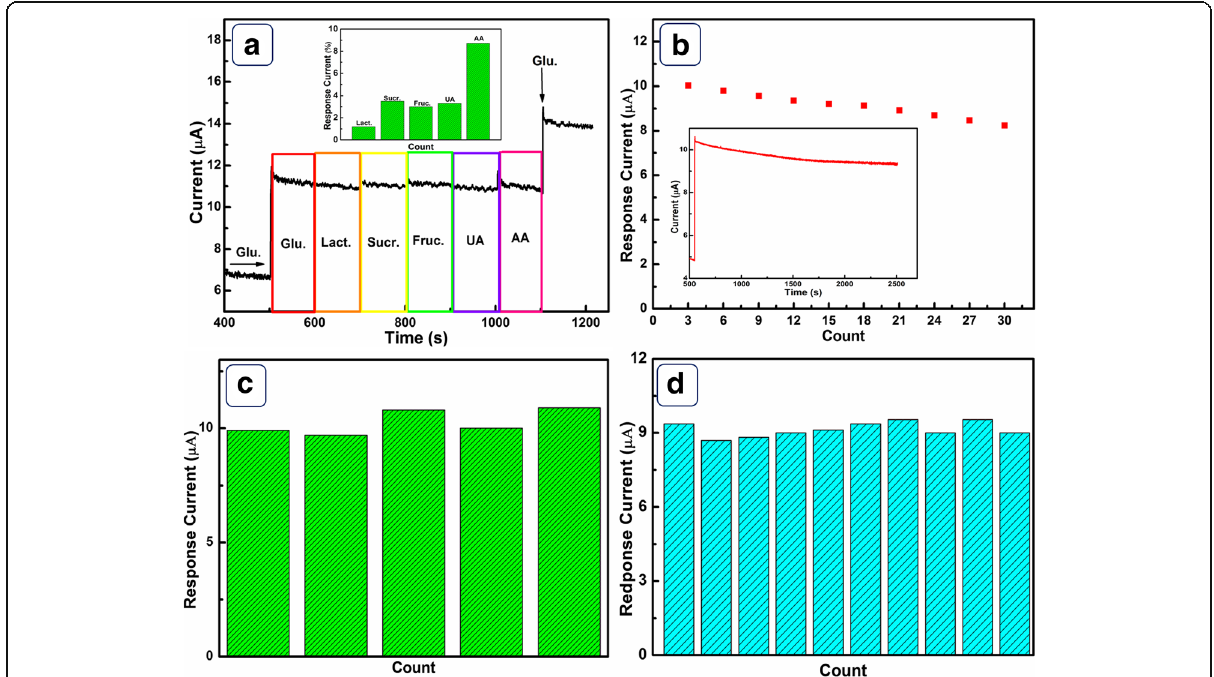
Fig. 7 a The current response of NiO HPA electrode to sequential addition of 50 μ M glucose and 5 μ M interfering species at an applied potential of 0.6 V. Inset is the statistical data of the interference current. b Long-term stability of NiO HPA electrode for 0.1 mM glucose. Inset is the stability of NiO HPA electrode with the running time. c Current responses of five NiO HPA electrodes towards 0.1 mM glucose. d Ten measurements of a NiO HPA electrode towards 0.1 mM